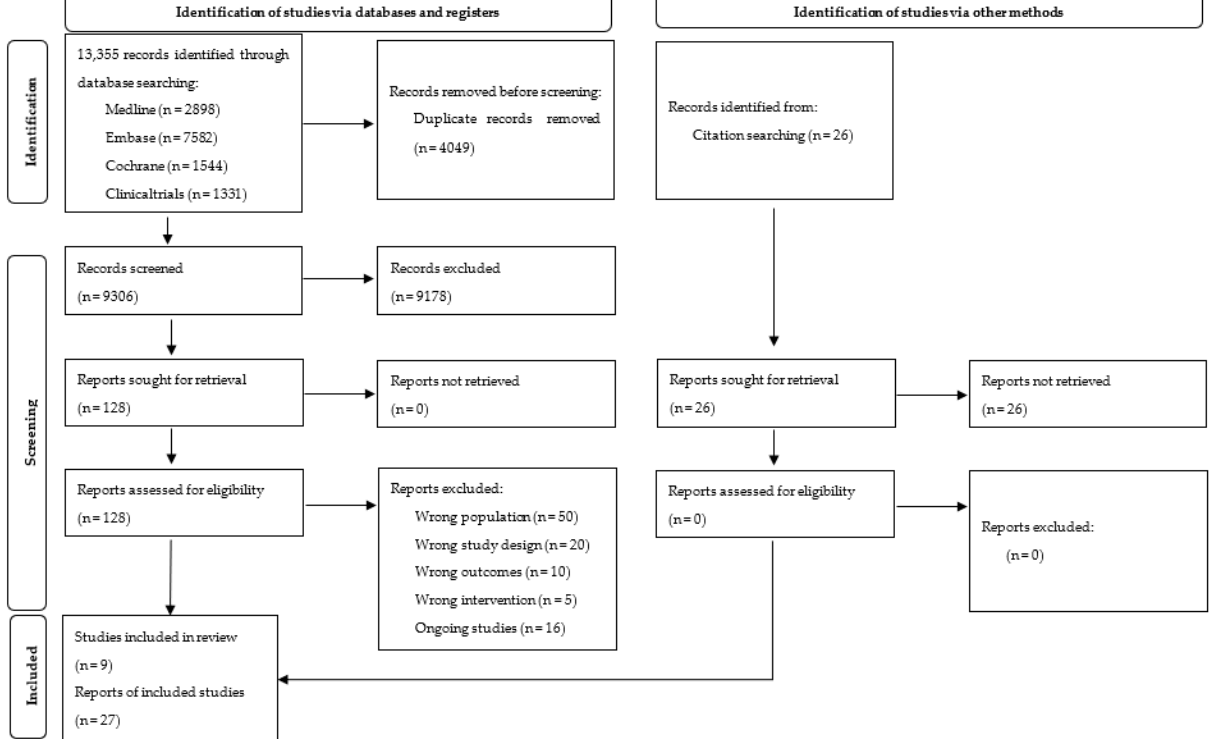
Figure 1. PRISMA 2020 Flow Diagram.